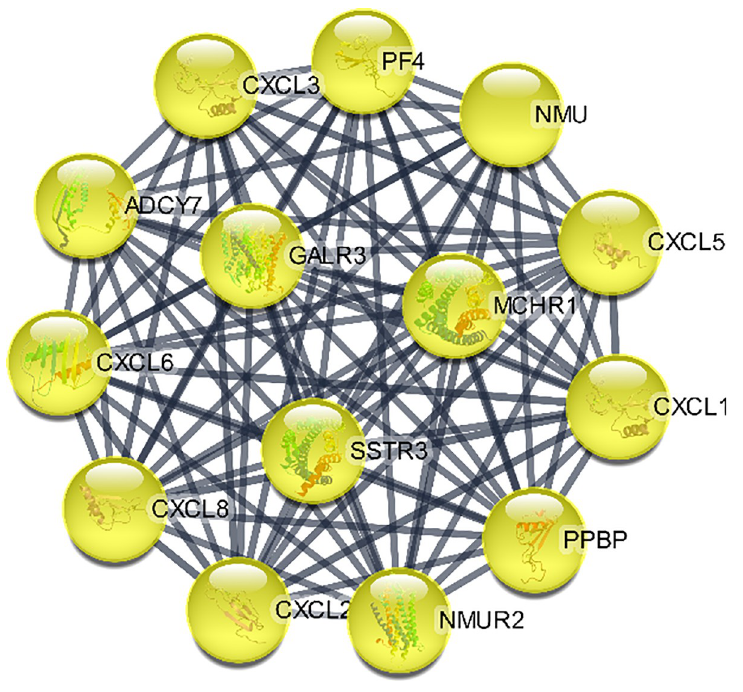
Fig 11. Cluster 3 based on MCODE